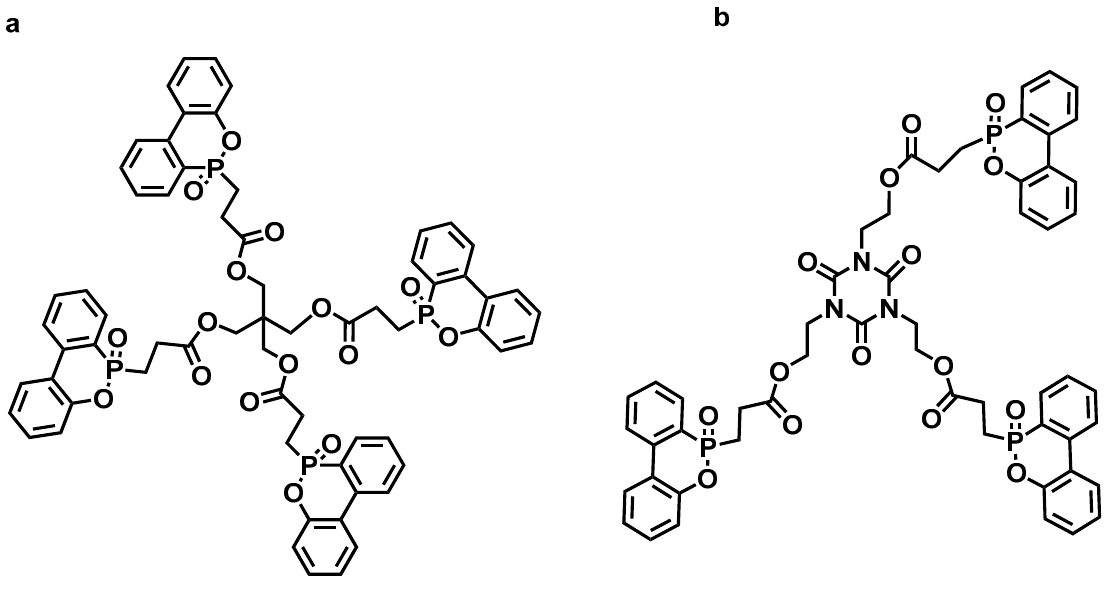
Figure 5. Structures of two phosphorus-containing flame retardants: ( a ) DOPP and ( b ) DOPI. Readapted with permission from Ref. [81], Copyright 2011, Elsevier Ltd.